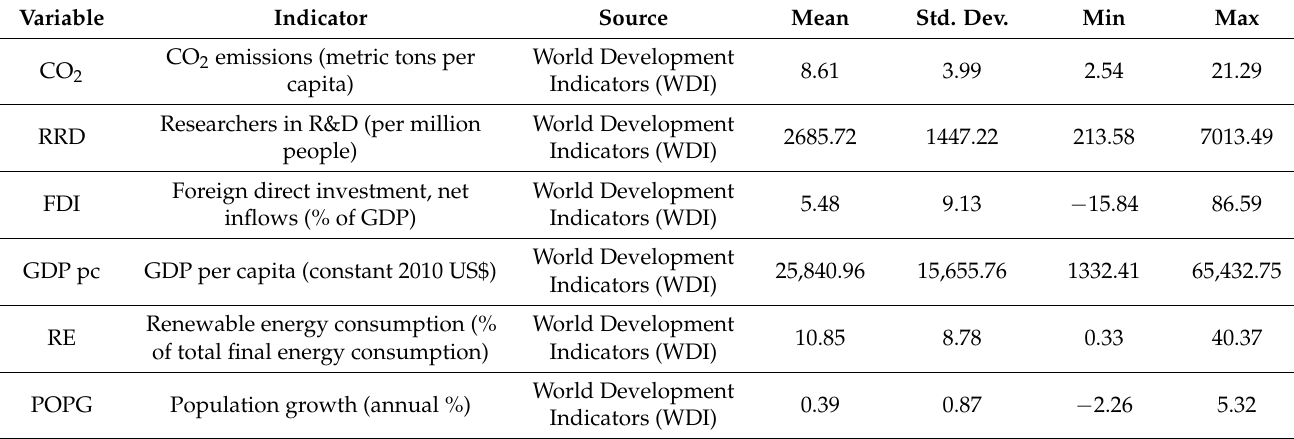
Table 1. Summary